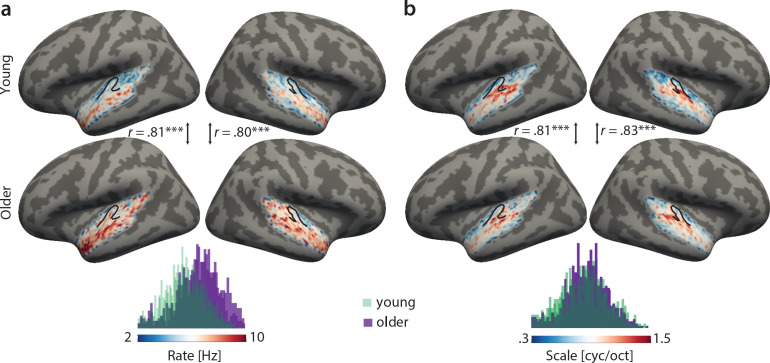
Group best-feature maps for temporal rate (a) and spectral scale (b).Group maps were obtained as median across subjects and shown on FreeSurfer’s fsaverage5 template. Black outlines indicate Heschl’s gyrus. Topographic organization in the young (upper panel) and older group (bottom panel) is significantly correlated (Pearson’s correlation coefficient) for best temporal rate (a) and best spectral scale (b). Histograms of best feature values are shown for the young (green) and older group (violet) above the colour bars. Note the shift of the distribution in older relative to young adults for temporal rate (a) but not spectral scale (b), indicating that older adults’ voxel-wise preferred temporal rates are shifted towards higher modulation rates. ***p<0.005.